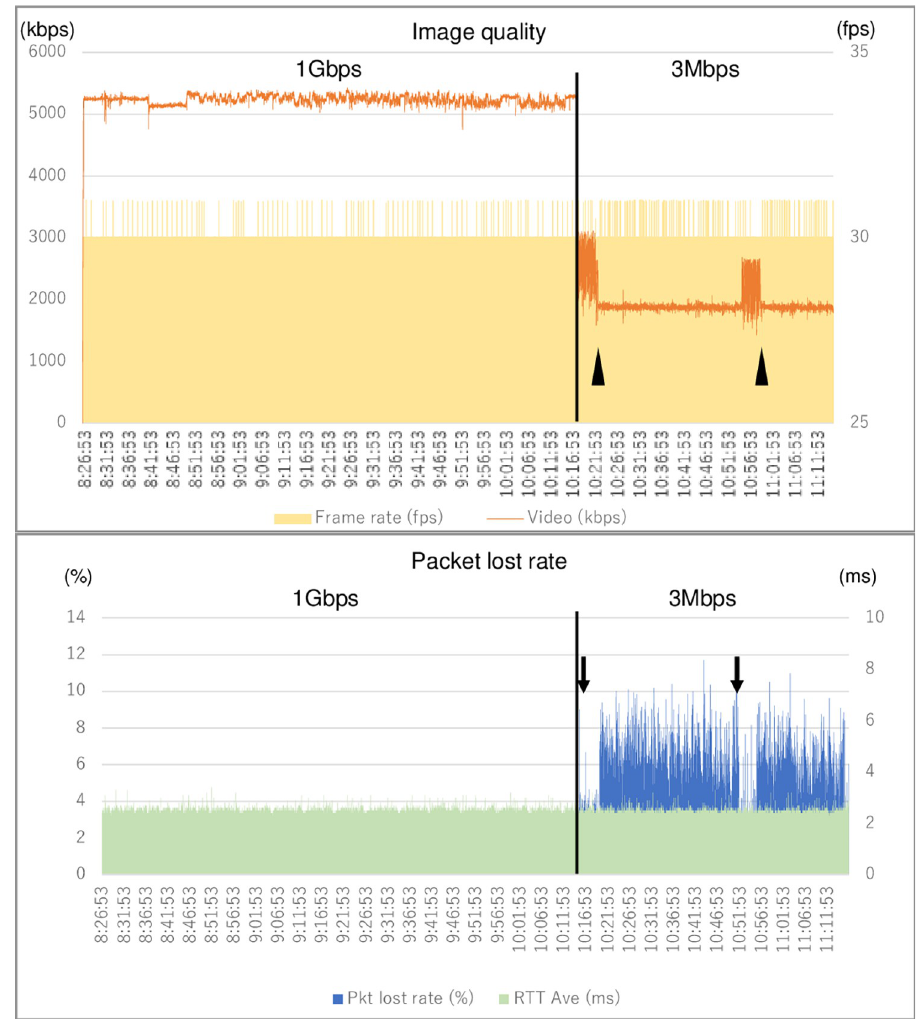
Fig 6. An example of the bandwidth, frame rate of the video, packet lost, and delay time. The video signal transmission rate was steady at 5.2 Mbps, and the average packet lost rate was as low as 0.042% with 1 Gbps. The average packet loss rate increased to 4.82% with 3 Mbps. When a subject began a robotic operation, the visual communication bandwidth was reduced to 2 Mbps because CODEC assigned a priority of 1 Mbps to the robot operation signal (arrowhead). The surgical procedure was completed, the amount of packet loss decreased (arrow). Regardless of bandwidth, the communication delay was less than 3 ms, Framerate (fps): Framerates per second, Video (kbps): Video transmission value loss (kilobits per second), Pkt lost rate: Packet lost